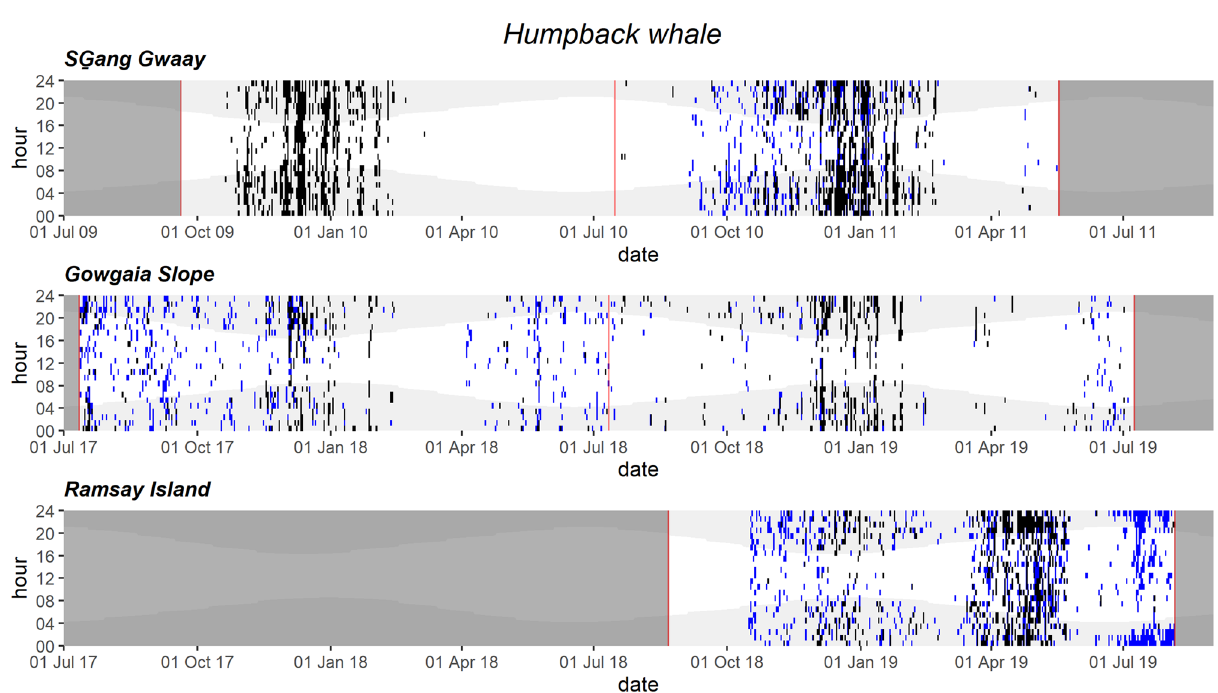
Figure 6. Daily and hourly occurrence of humpback whale vocalizations at SG ̱ ang Gwaay, Gowgaia Slope and Ramsay Island in 1-h bins. Blue dots indicate automated detections. Black dots indicate confirmed occurrence. Red lines indicate recorder deployment and retrieval dates. Dark grey areas indicate a lack of recordings. Light grey shaded areas indicate hours of